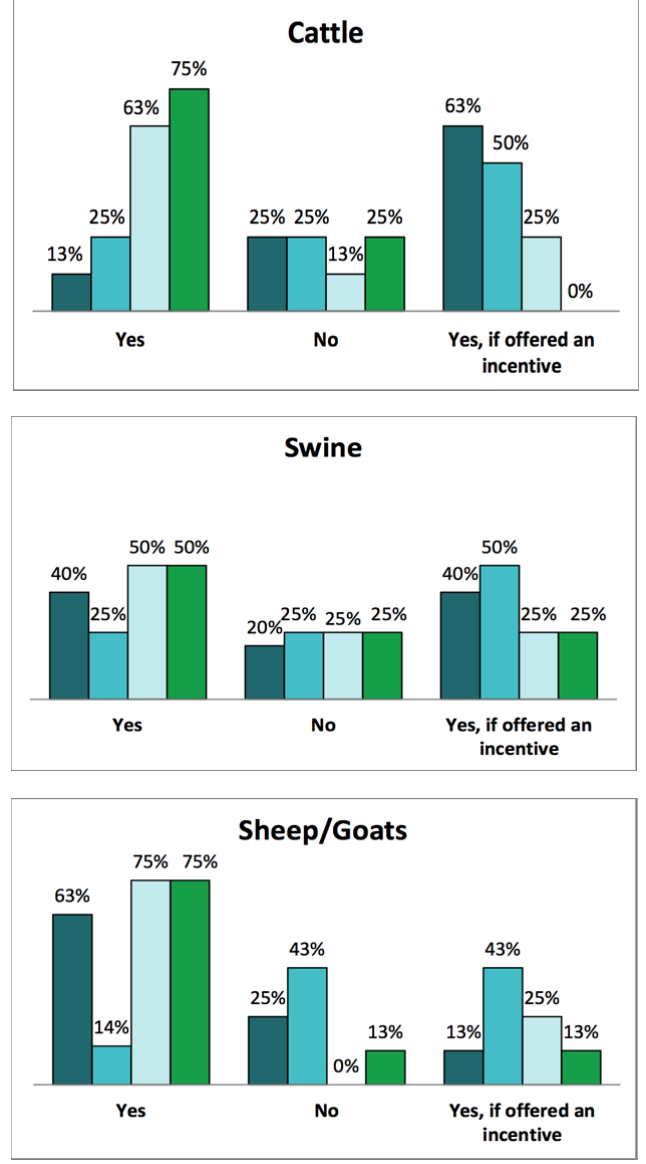
Figure 3. Percentage of livestock producers who said they would commit to having livestock ready for slaughter by season and livestock type, if altering the birthing cycle for at least a portion of their herd would make a USDA-inspected livestock processing facility